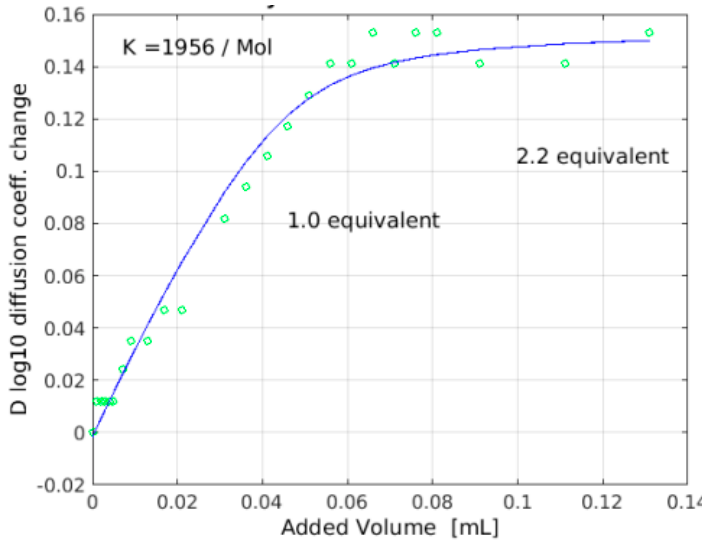
Figure 5. Titration of N -Ac- D -Ala- D -Ala into eremomycin as monitored by NMR diffusion constants (DOSY). Though the change of diffusion coefficient is negative on the y axis, they are shown as positive values for convenience of fitting.